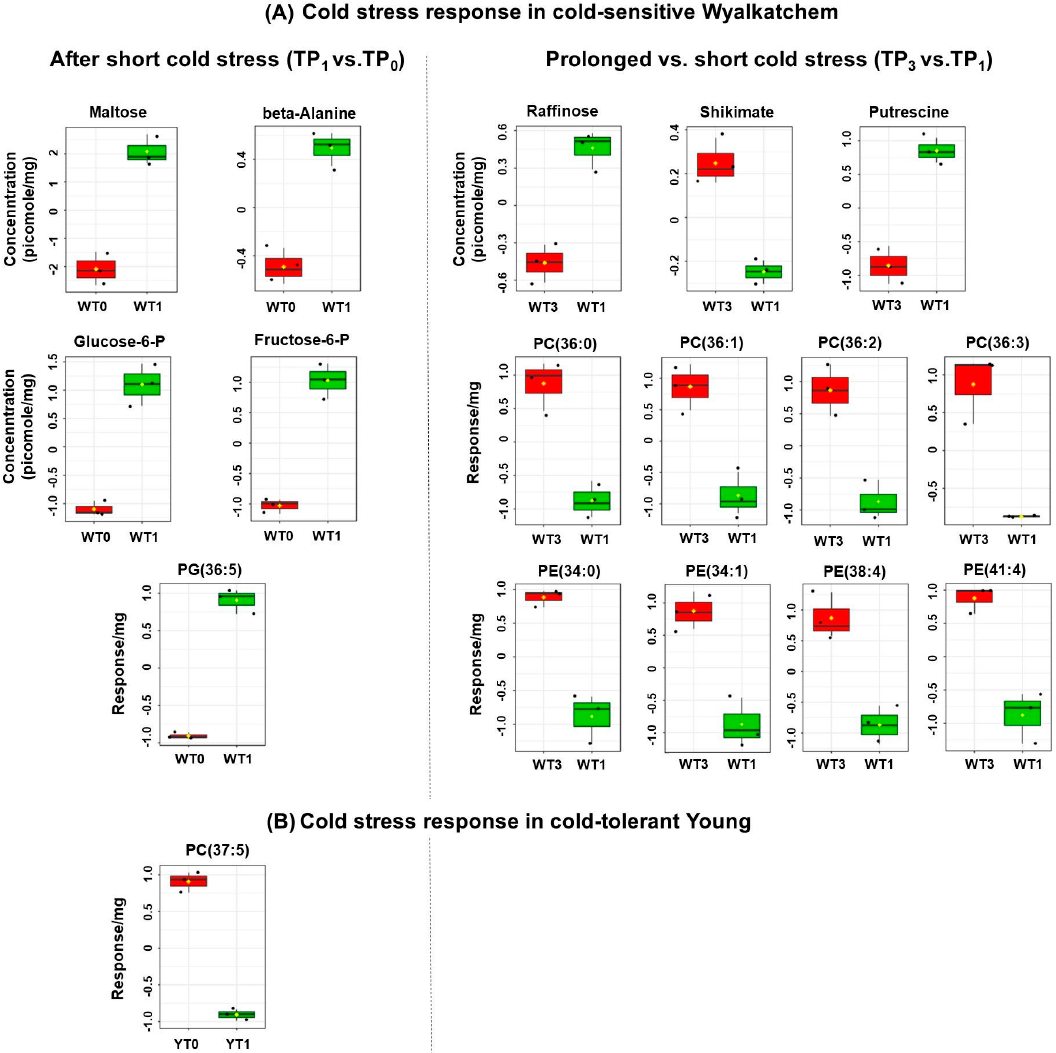
Figure 2. Pairwise comparisons of normalized and log 2 -transformed primary metabolites and lipids in the spikes of cold-sensitive Wyalkatchem ( A ) and cold-tolerant Young ( B ) after one night (TP 1 vs. TP 0 ) and prolonged (TP 3 vs. TP 1 ) of cold treatment. Metabolites and lipids shown are significantly different and the significance levels were determined using the Benjamini and Hochberg method [45] with a false discovery rate (FDR)-adjusted p -value of 0.05 as cut-off. There were three biological replicates ( n = 3) for all the measured metabolites and lipids. W = Wyalkatchem; Y = Young